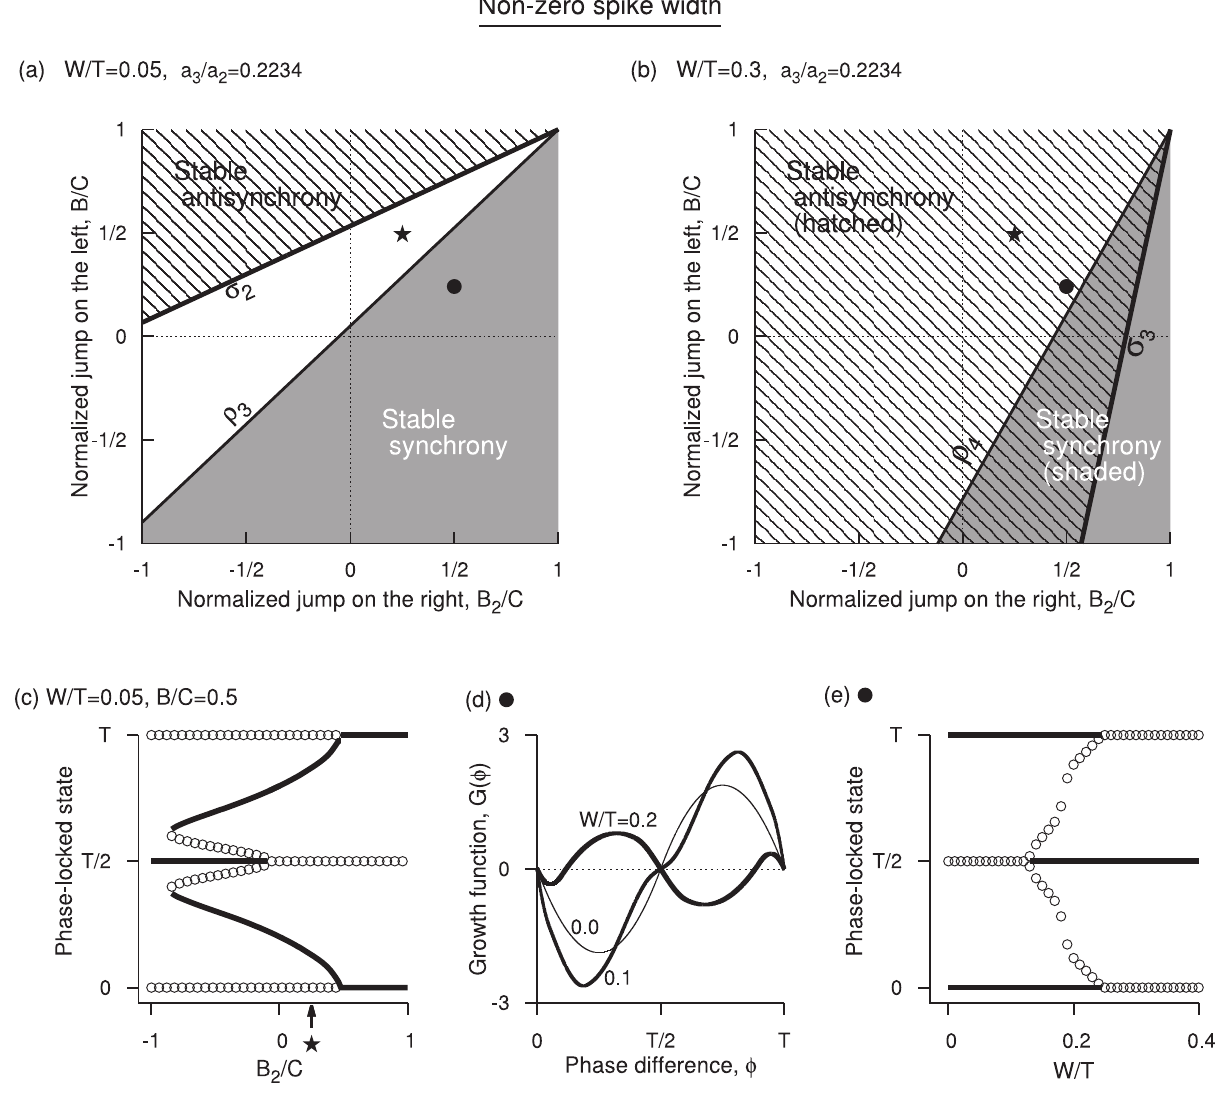
Figure 4. Edge effects when spike width is non-zero. (a) Stable synchrony (shaded) and stable antisynchrony (hatched) regions in B 2 = C and B = C space for small spike width W = T ~ 0 : 05 at a 3 = a 2 ~ 0 : 2234 . The white region holds other non-zero stable phase-locked solutions. (b) Same as in (a) but for large spike width W = T ~ 0 : 3 . (c) One-parameter bifurcation diagram as a function of B 2 = C at small spike width and B = C ~ 0 : 5 , and W = T ~ 0 : 05 . The non-zero phase-locked states are found to be bistable with anti-synchronous state, and are not very close to the synchronous state as was the case for zero spike width. (d) Growth function at three levels of W = T when B = C ~ 0 : 25 and B 2 = C ~ 0 : 5 . When B 2 and B are chosen such that the system is in a synchronous state, increasing spike width eventually makes it unstable, but the stability is maintained until the spike width is large. (e) One-parameter bifurcation diagram as a function of spike width corresponding to the parameters in (d). The antisynchrony becomes stable here at W = T ~ 0 : 13 . Note that the stability boundaries and transitions are functions of the ratios W = T , a 3 = a 2 , and B = C . Thus, for example, the diagram in (a) is valid for any period and spike width as along as W = T ~ 0 : 05 .